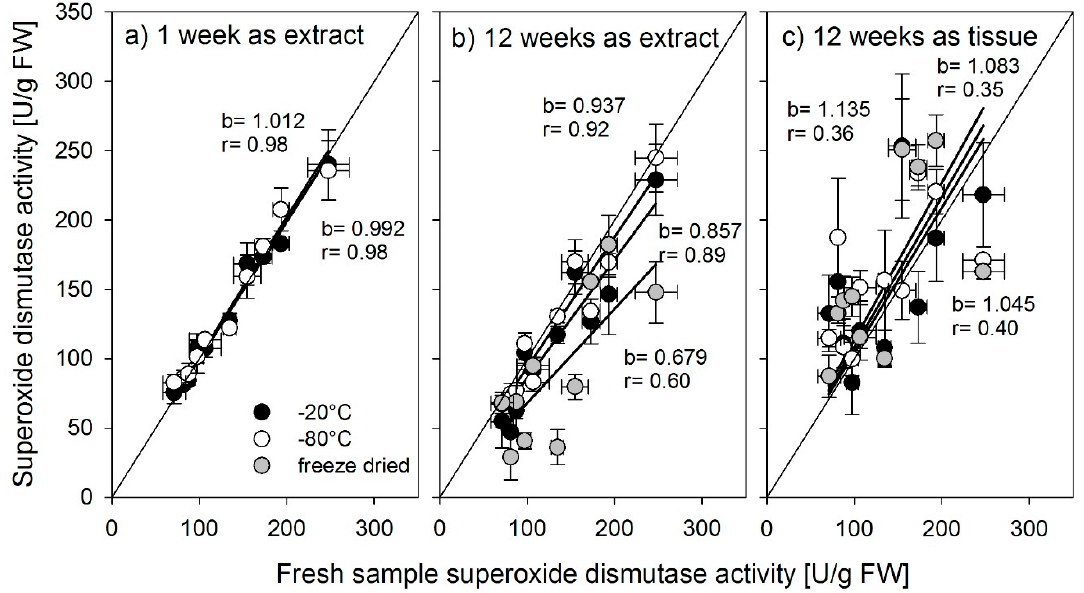
Figure 5. Superoxide dismutase activity determined from fresh samples compared with activity determined after storage at − 20 °C, (black symbols), − 80 °C (open symbols), or freeze-dried extracts of tissue (gray symbols) for ( a ) 1 week storage time or ( b,c ) 12 weeks storage time. b = slope of the regression line, r = the correlation coefficient r 2 . Error bars = standard error of mean (n = 3).